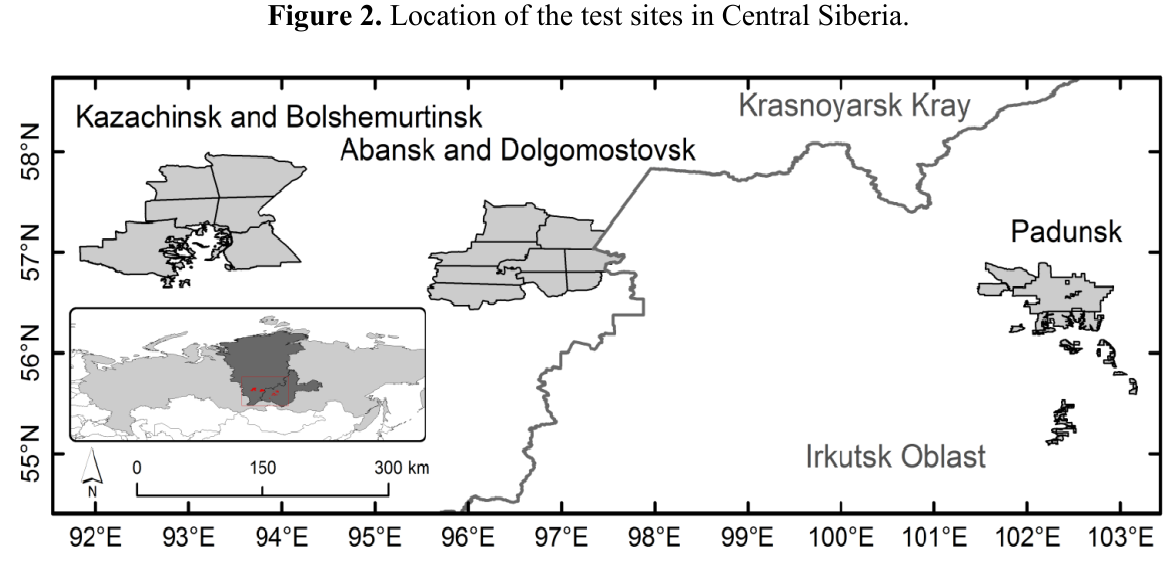
Figure 2. Location of the test sites in Central